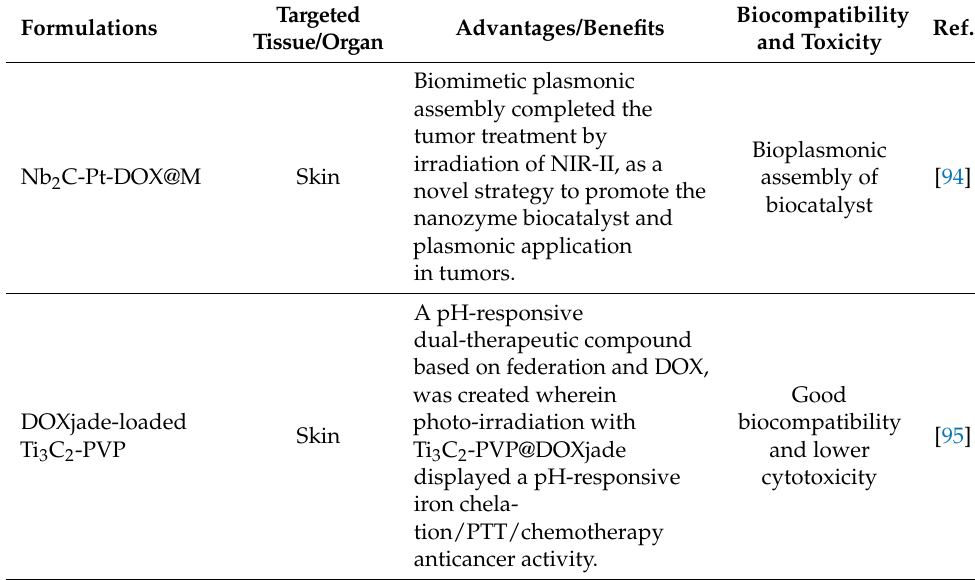
Figure 10. The preparative process and function of designed MXenes for cancer nanotherapy [106]. A variety of MXene-based micro-and nano systems have been designed for targeted cancer therapy (Table 1). Table 1. Different MXene-based systems for cancer